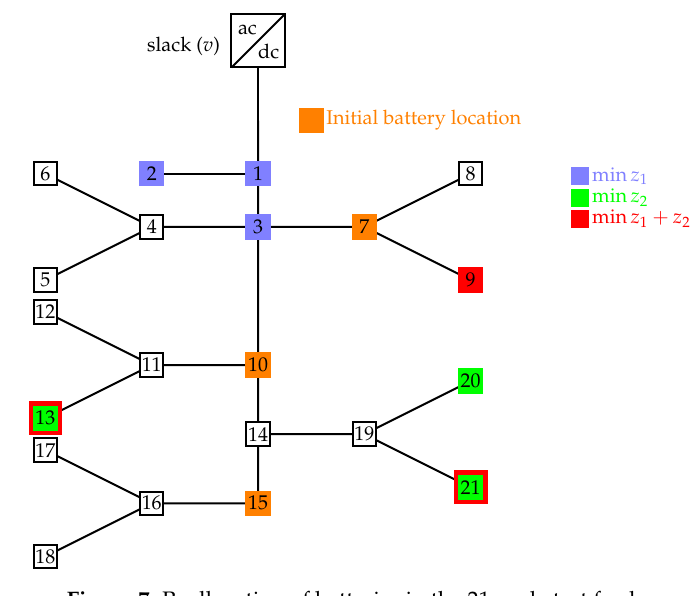
Figure 7. Reallocation of batteries in the 21-node test